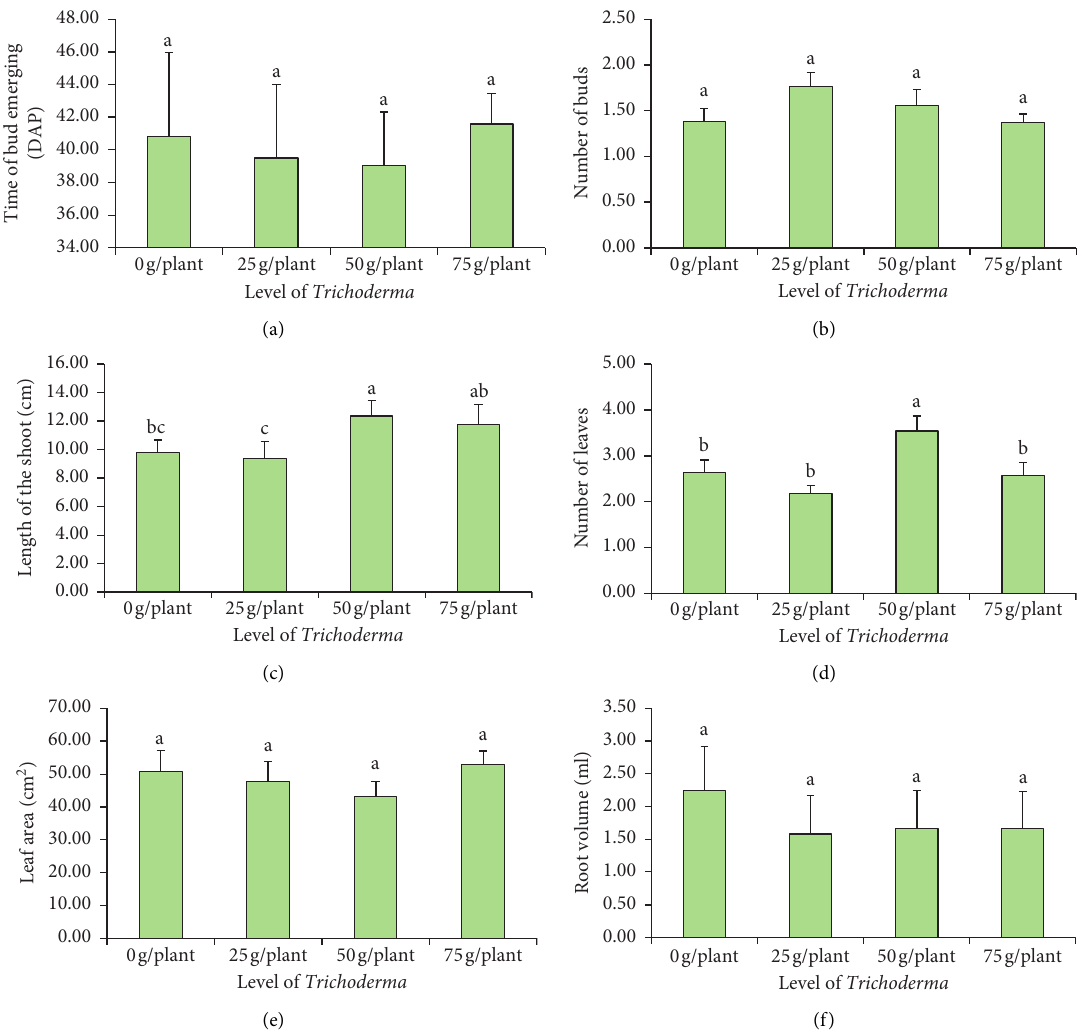
Figure 2: Effect of Trichoderma on (a) shoot emergence time, (b) shoot number, (c) shoot length, (d) the number of leaves, (e) leaf area, and (f) root volume of black pepper seedlings (after 8 weeks of planting). Different letters indicate significant differences among treatments as determined by Tukey’s HSD test at the p < 0 . 05 level. Vertical bars represent